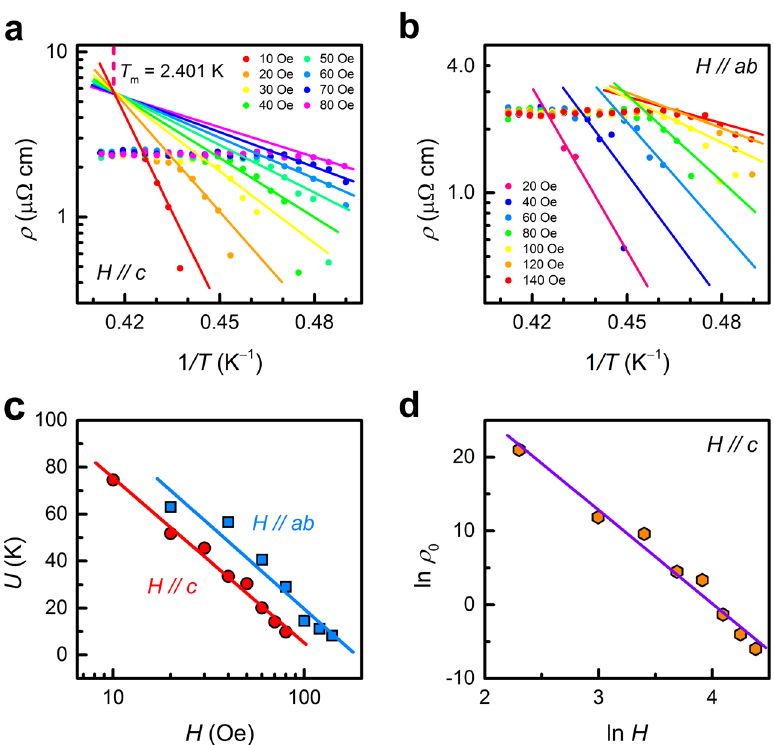
Fig. 4 Arrhenius plot of resistivity for AuSn 4 . Arrhenius plot of resistivity for AuSn 4 in magnetic fi elds: a parallel to the crystal c -axis and b ab plane. Solid lines are corresponding fi tting results from the Arrhenius relation. c Field-dependent activation energies extracted from the Arrhenius plot of resistivity on a semi-logarithmic scale. Solid lines are fi tting results from the function U ( H ) = U 0 ln( H 0 / H ). d A ln ρ 0 – ln H plot extracted from the Arrhenius plot of resistivity with H // c -axis. The solid line represents the relation of ρ 0 ∝ H − p with p ≈